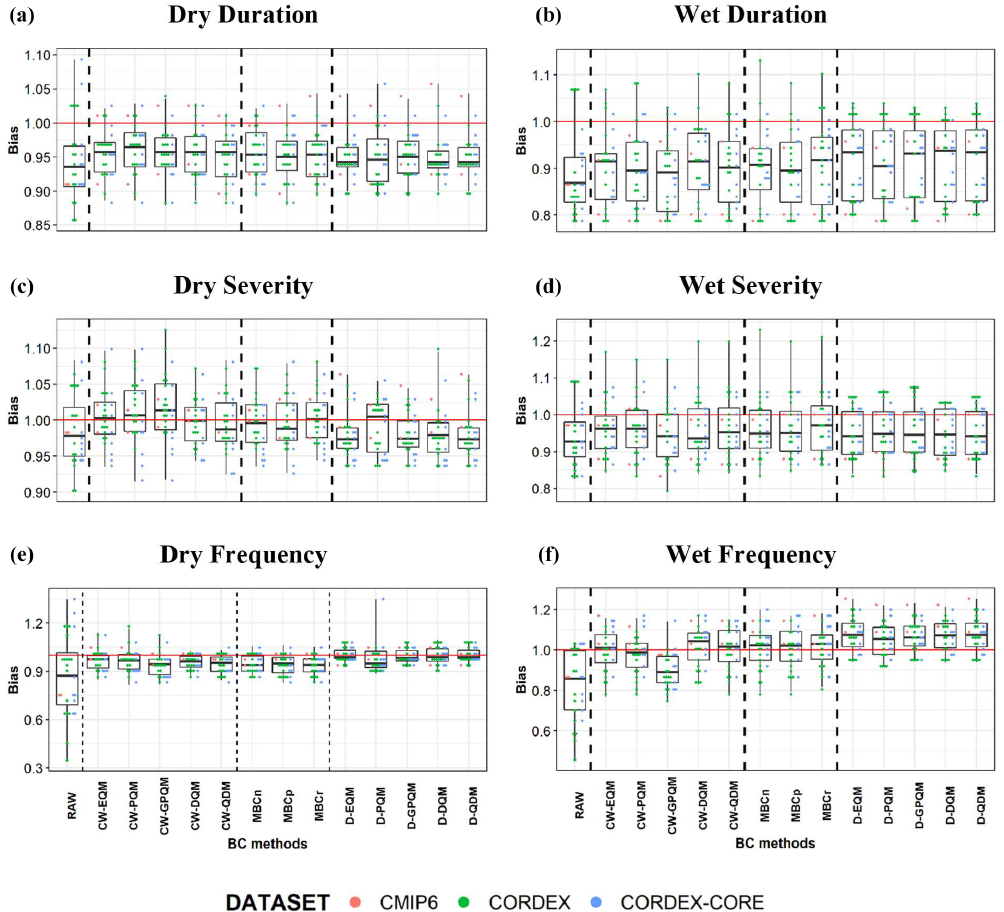
Figure 5. Biases (as a ratio of model to reference) in spatially averaged SPEI indices over Upper Jhelum Basin computed from the raw (first box in each panel) and bias-corrected data (rest of the boxes; CW: component-wise; D: direct). Each box represents the interquartile range of biases across all models, which are depicted individually with colored dots (CMIP6 in red, CORDEX in green, CORDEX-CORE in blue), and whiskers expand the full range of biases. Horizontal red lines depict perfect performance, for